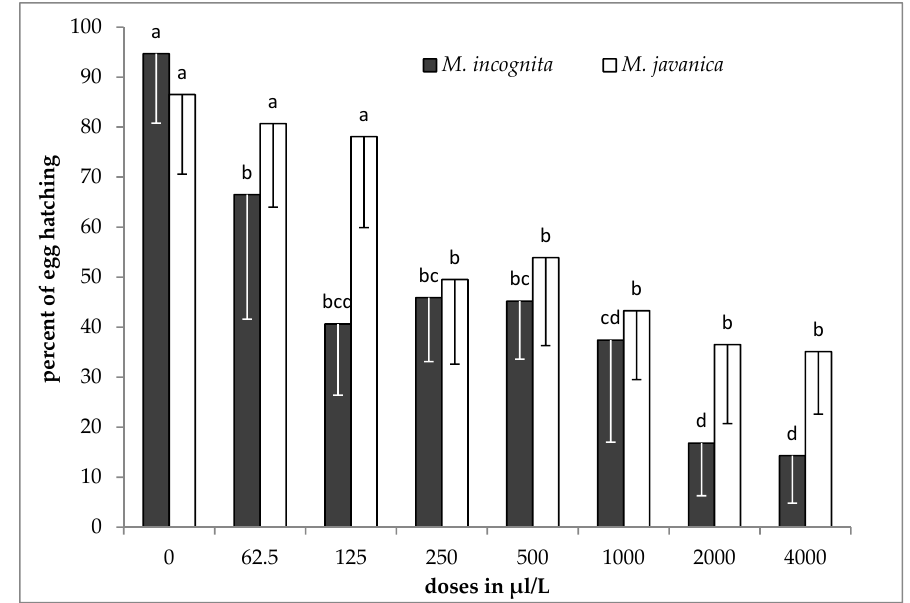
Figure 3. E ff ect of essential oil on hatching of M. incognita and M. javanica J2s after immersion in test solutions at the doses of 0, 62.5, 125, 250, 500, 1000 and 2000 µ L / L for 35 days. Bars with the same color followed by the same letter are not significantly di ff erent. Error bars represent the standard deviation of